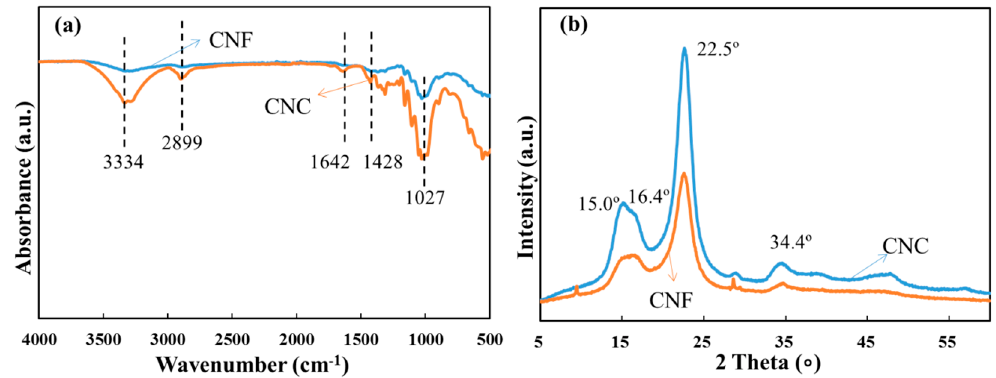
Figure 1. Characterization of CNFs and CNCs: ( a ) FT-IR transmittance spectra; ( b ) X-ray diffraction spectra.